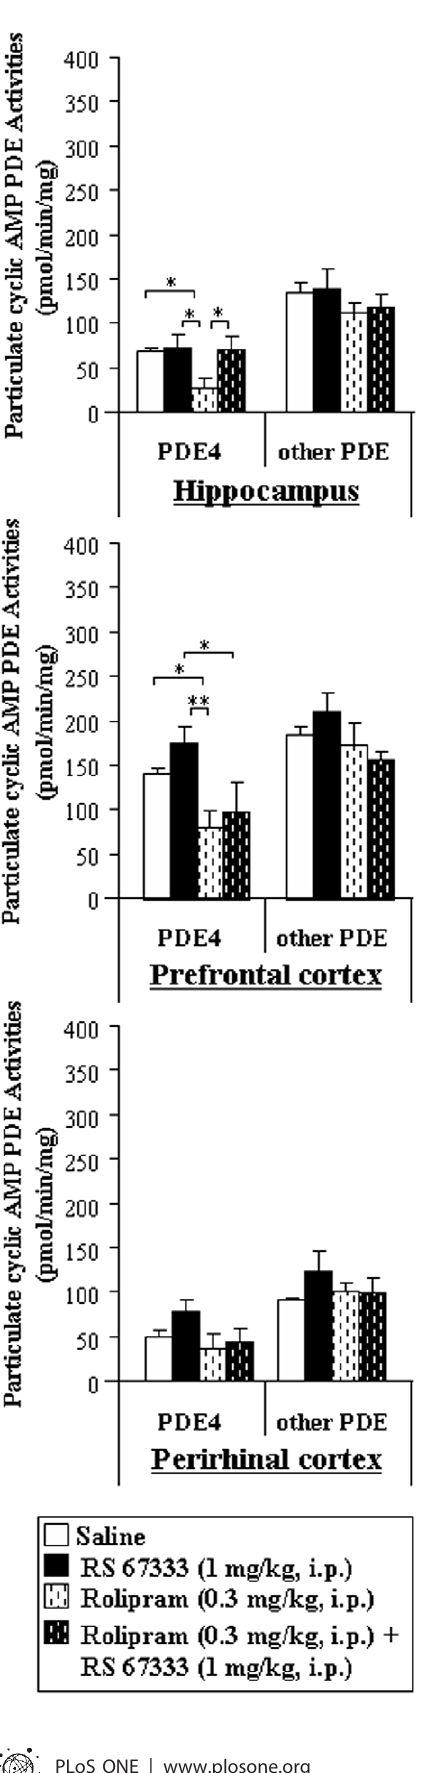
Figure 4. Rolipram (0.3 mg/kg, i.p.) specifically inhibits PDE4 activities in hippocampus, prefrontal cortex and perirhinal cortex from rats. Rats were injected with the PDE4 inhibitor (rolipram, 0.3 mg/kg), and then with saline or the 5-HT4 receptor agonist (RS 67333, 1 mg/kg), respectively 45 minutes and 30 minutes before the sample phase of the object recognition task. Immediately after the testing phase, both particulate and soluble fractions from the hippocampus, the prefrontal cortex and perirhinal cortex were isolated and the particulate fraction was assayed for rolipram (10 m M)-sensitive PDE activities. Rolipram-sensitive and –insensitive PDE activities were expressed as pmolcAMPhydrolysed/min/mg protein. Results are means 6 SEM of four independent subcellular fractionations performed in triplicate. Within each subcellular compartment, * indicated significant differences of PDE activity as compared with other treatment within a type of PDE activity (PDE4 or other PDE) (*, P , 0.05, **, P , 0.01, ANOVA followed by Fisher’s LSD test).